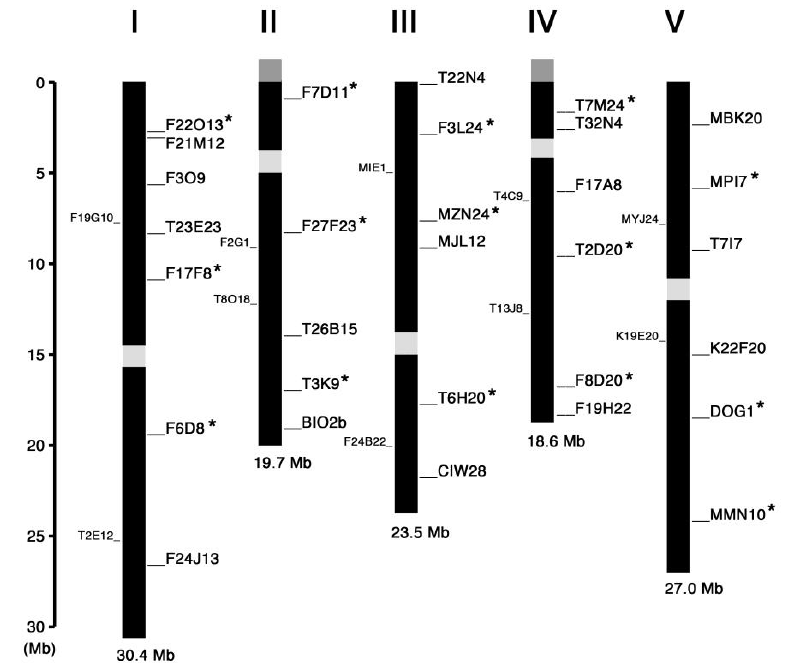
Figure 1. Linkage map of the InDel markers on Arabidopsis chromosomes. The markers examined in this study are indicated in the right-hand side of each chromosome whose number is shown on the top. The markers recommended as a first choice for rough mapping are asterisked. The InDel markers reported by Zhang et al. [13] are indicated in the left-hand side of each chromosome. The centromere regions are shown in light gray boxes. Nucleolus organizer regions coding for ribosomal RNAs are shown in dark gray boxes at the end of upper arm of chromosomes II and IV.